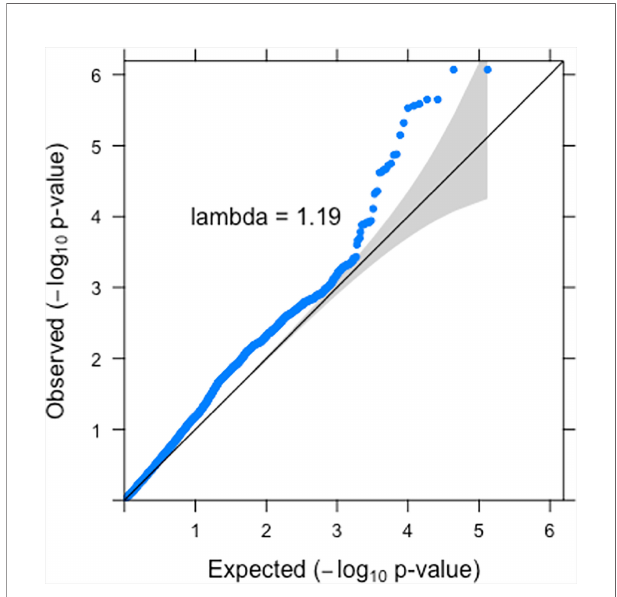
FIGURE 1 | Enrichment of CRP-QTLs in appendicitis GWAS. CRP, C-reactive protein; QTLs, quantitative trait loci; GWAS, genome-wide association